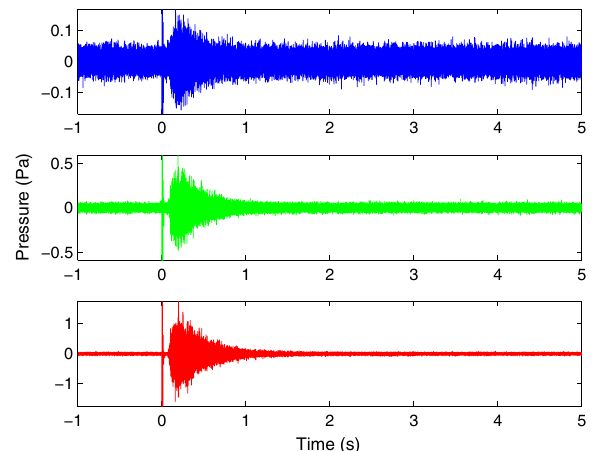
FIG. 11. Filtered signals during Test 2 (top), Test 1 (middle), and Test 3 (bottom) for microphone 1. A noise spike with a slow refraction decay is generated in the sensor electronics by radiation effects and it can be used as an event trigger of the beam impact. A high-pass filter of third order at 100 Hz removes the slow decay and reveals the real sound data.